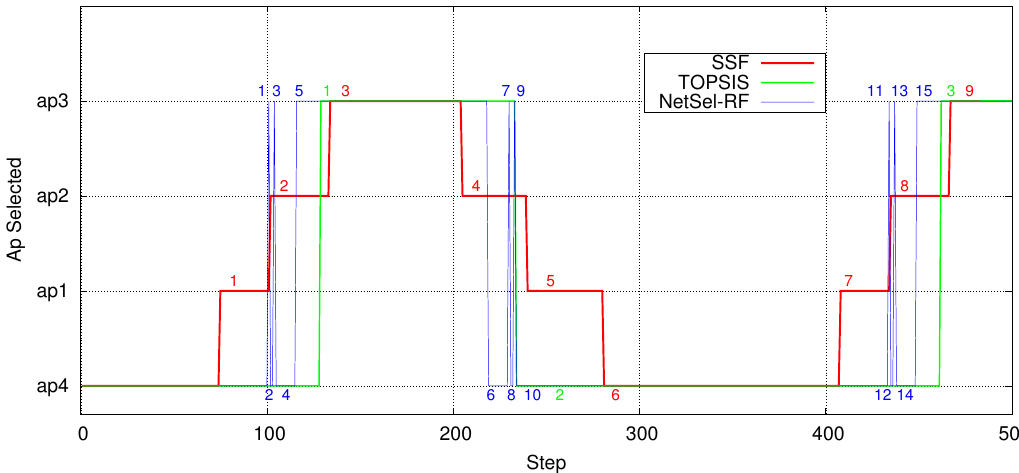
Figure 5. Number of handovers: NetSel-RF without movements